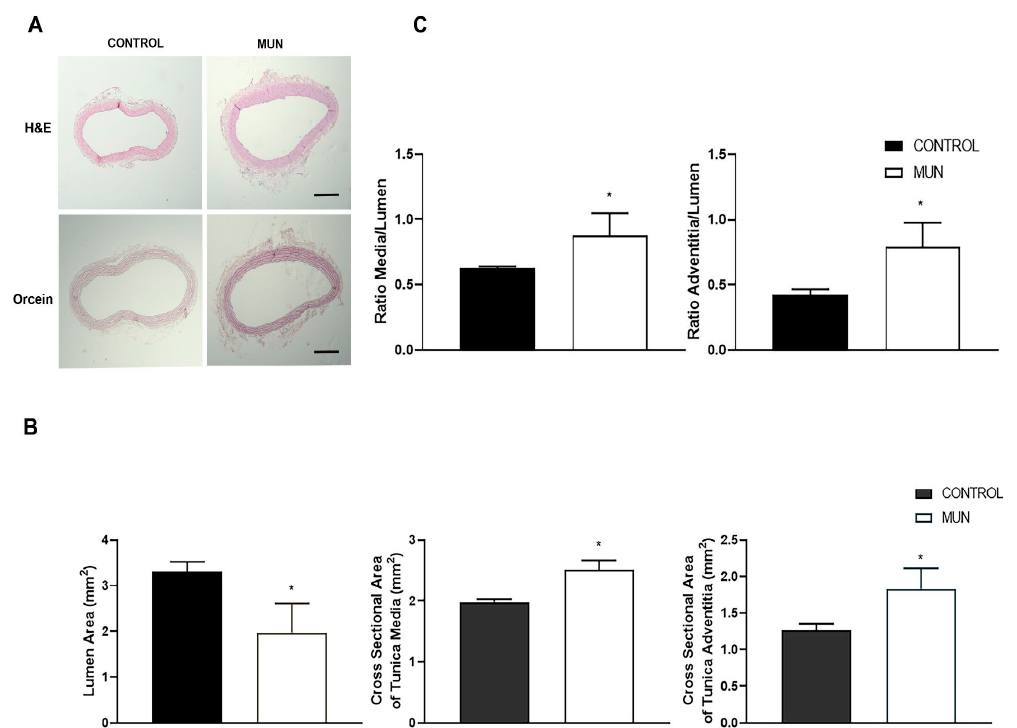
Figure 6. Influence of fetal undernutrition on mesenteric artery morphology in 6-month-old male offspring from rats exposed to maternal undernutrition during pregnancy (MUN) and rats fed ad libitum (CONTROL). Representative images ( A ) obtained from hematoxylin-eosin (scare bar = 300 µ m) and orcein (scare bar = 500 μ m) stained mesenteric arteries from CONTROL and MUN; the graphics show ( B ) the area of lumen, of tunica media and of tunica adventitia; ( C ) the ratio media/lumen and the ratio adventitia/lumen. Values are mean ± s.e.m. from 6 rats in each group. Significant differences from the respective control rat: * p < 0.05.